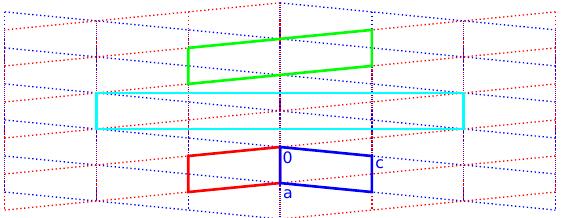
Figure 8. Direct lattice of the unit cell as described in Table 2, viewed in the ac plane. Blue and red indicate the individual unit cells ( P 2 1 / n setting). Green and cyan, respectively, indicate monoclinic-P and orthorhombic-C twin supercells. The blue and red lattices are derived from the monoclinic superlattice (see Scheme